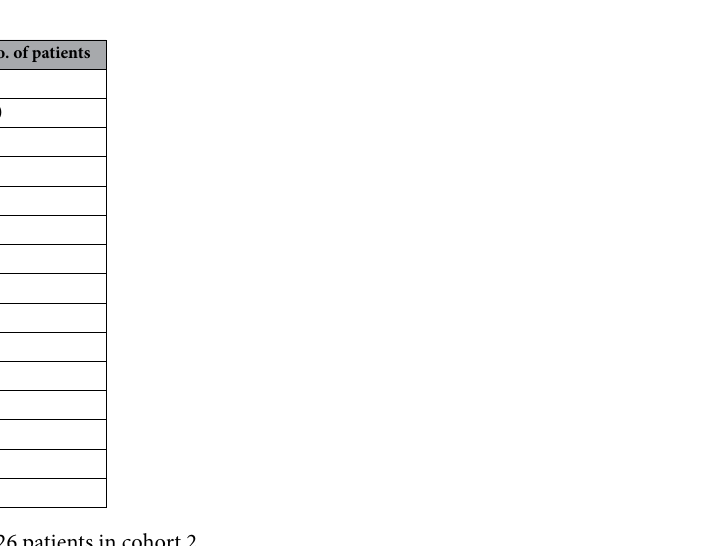
Table 2. Demographic data of 26 patients in cohort